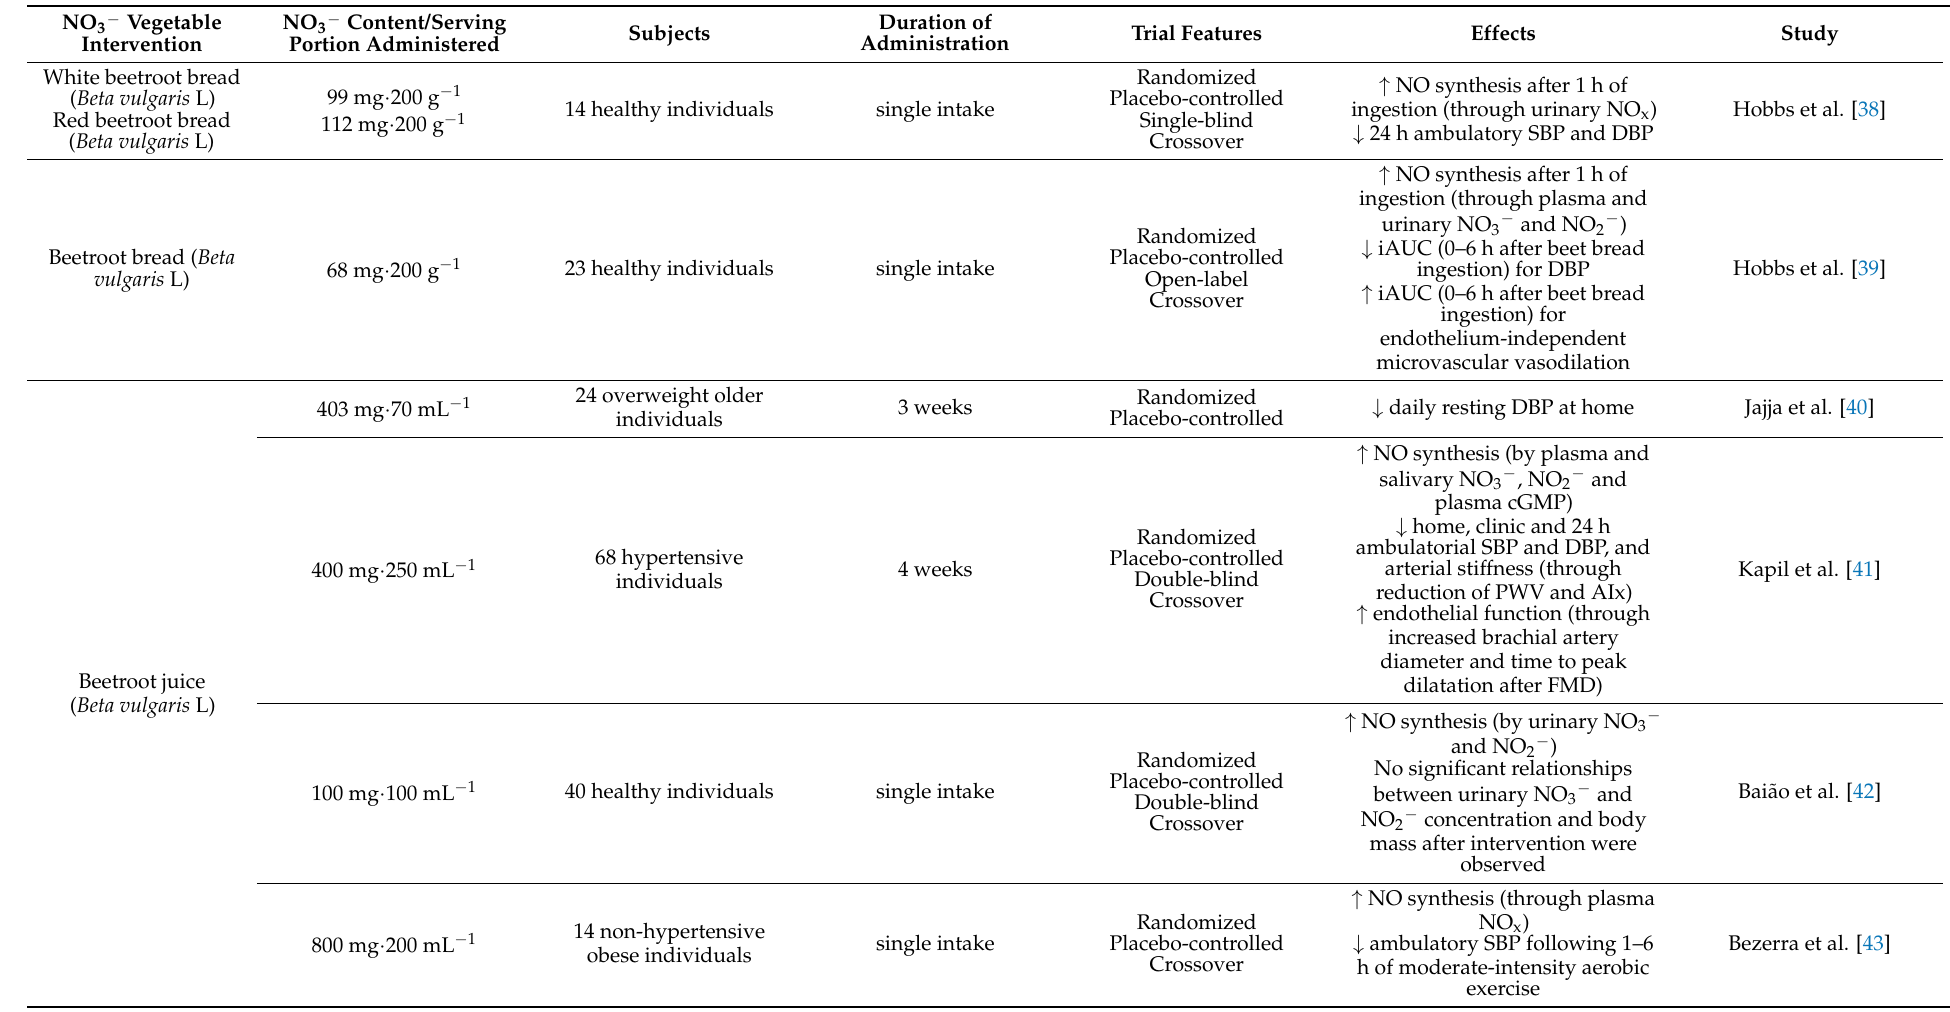
Table 2. Selected clinical trials from 2012 to 2020 compared considering administered NO 3 − content, intervention duration, level of systemic increase in NO evaluated by plasma NO 3 − and NO 2 − levels and improvements in primary and advanced hemodynamic parameters in healthy individuals and in patients presenting impaired vascular